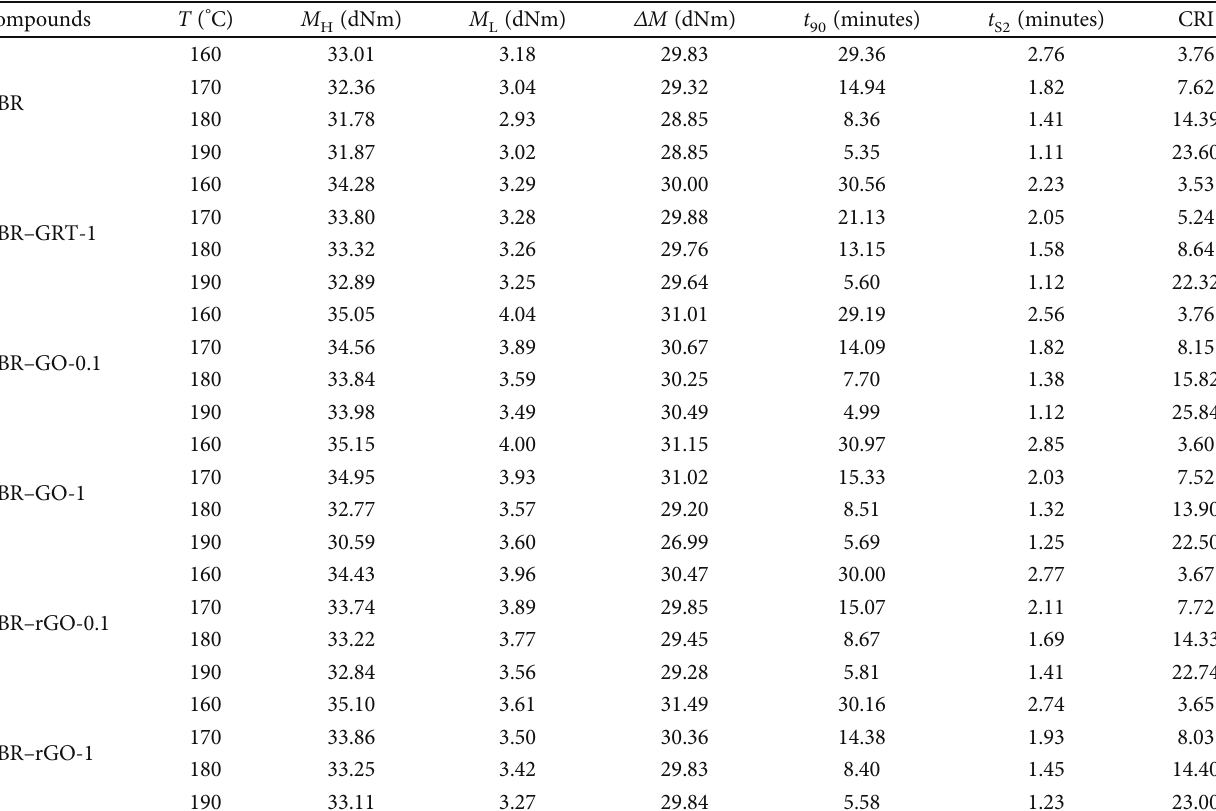
Table 2: Cure properties of non-activated sulfur cured NBR